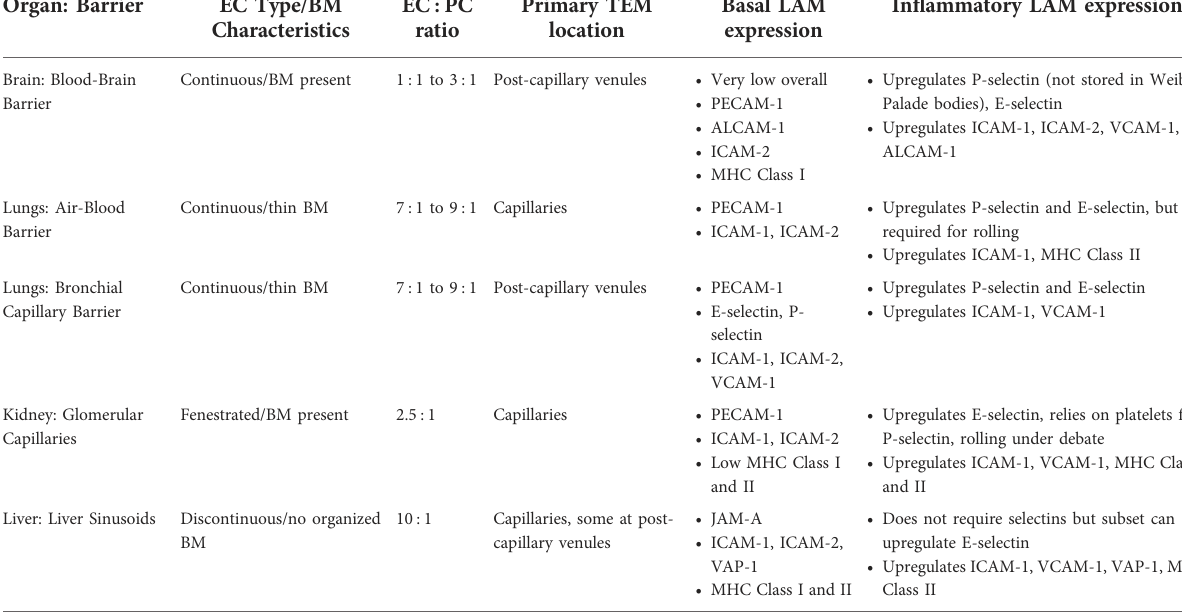
TABLE 1 Endothelial Cell characteristics at sites of leukocyte transmigration. Organ: